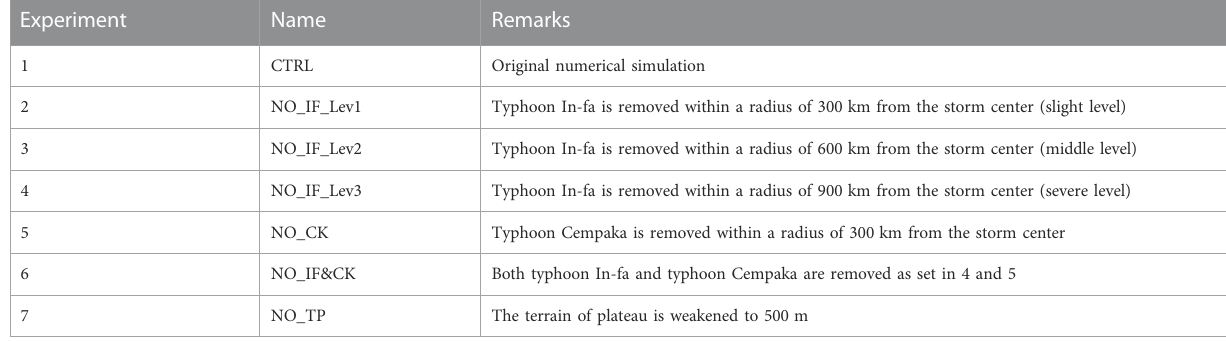
TABLE 2 List of